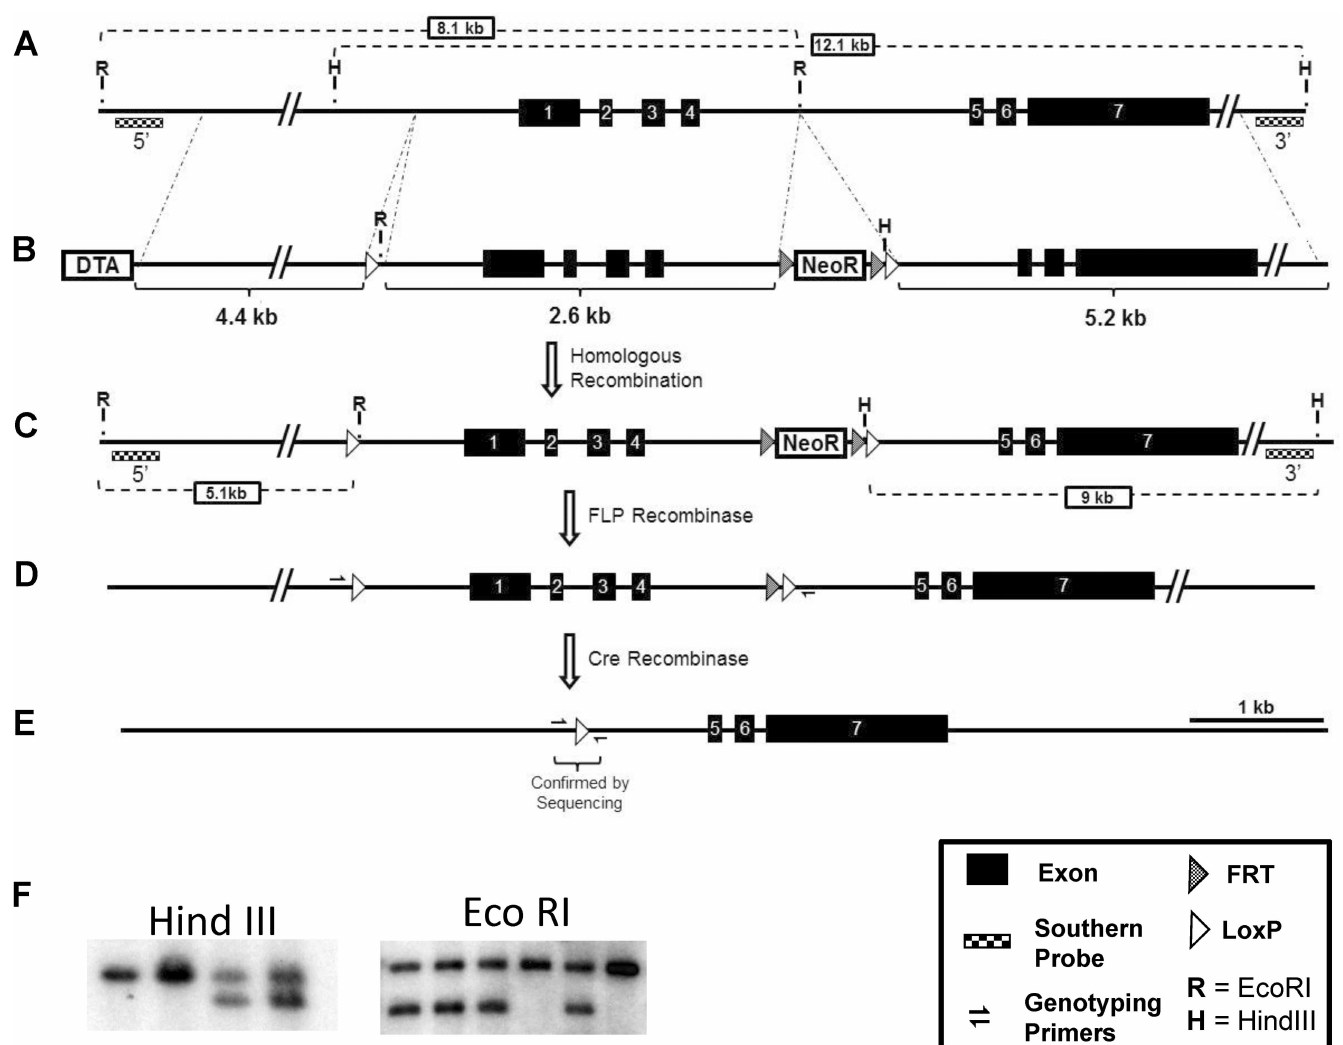
Fig 1. Generation of Ephx3 -/- mice. A) Wild type Ephx3 locus on the reverse strand of chromosome17:b1. B) Targeting vector to introduce LoxP sites flanking the promoter regionand first four exons of Ephx3 . Targeting vector constructed with FRT -site flankedneomycinresistancepositive selection and MC1-DTA negative selection.C) Targeted Ephx3 locus followinghomologous recombination. D) Ephx3 “flox” locus followingexcisionof neomycin resistancecassette via in vivo FLP recombinase exposure. E) Ephx3 null allelegeneratedby breedingto germline expressingCre recombinase mouse line (Prm-Cre). F) Representative Southernblots using both the 5’ and 3’ probesto confirm proper recombination event. Only relevant restriction enzymes sites shown with expectedfragment